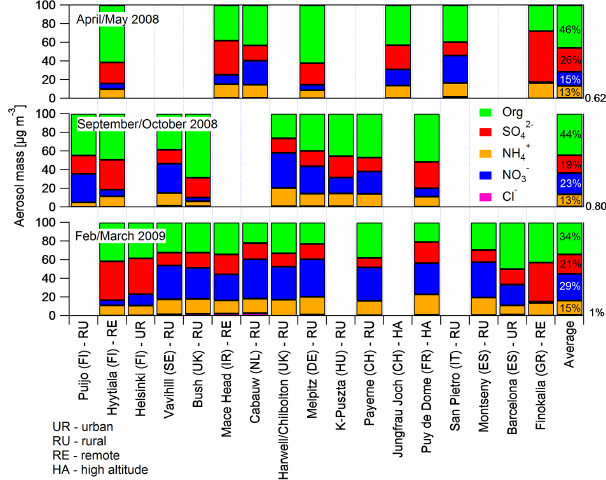
Figure 9. Relative (non-refractory) submicron aerosol composition measured with an aerosol mass spectrometer (AMS) network dur- ing three pan-European EMEP/EUCAARI campaigns. The sites are arranged from north to